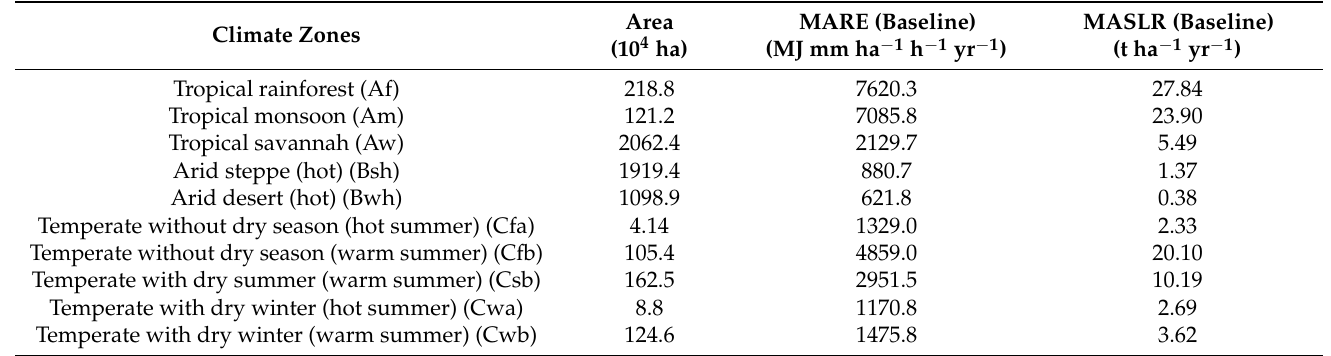
Table 7. The estimated baseline soil erosion rates per the Climatic Zones of